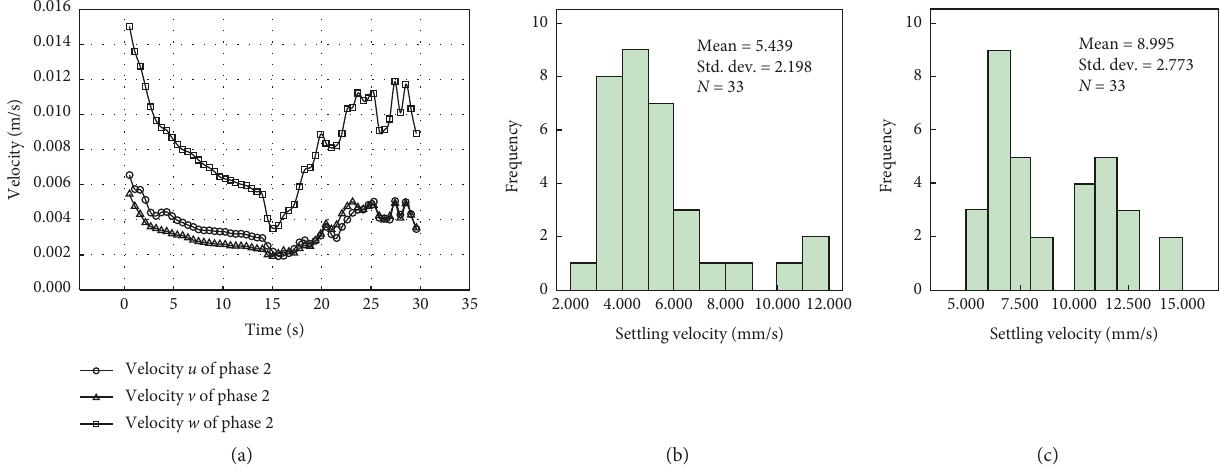
Figure 5: Settling velocities of particle or floc in model and experiments. (a) Time series of the settling velocities, phase 2 represents particles or flocs. u is the direction of settlement; v and w are the radial directions perpendicular to u . (b) Statistics of the settling velocities in experiments when the particle concentration in suspension is 5g/L. (c) Statistics of the settling velocities in experiments when the particle concentration in suspension is 15 g/L. (a) Model. (b) Experiments (particle concentration � 5g/L). (c) Experiments (particle concen- tration � 15g/L).